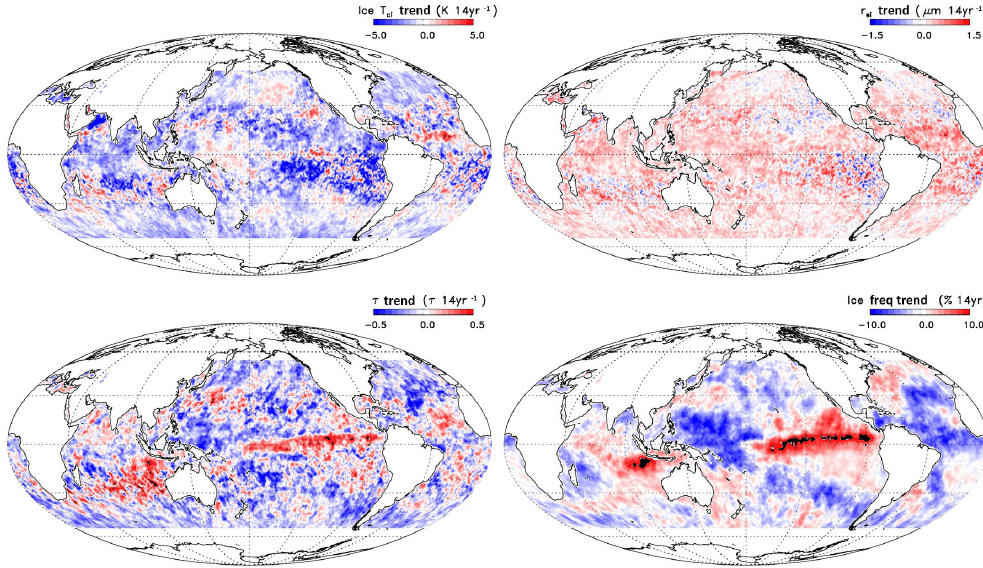
Figure 3. The global 14-year trends for the fields in Fig. 1. Note that the minimum and maximum trends may exceed those indicated in the colour